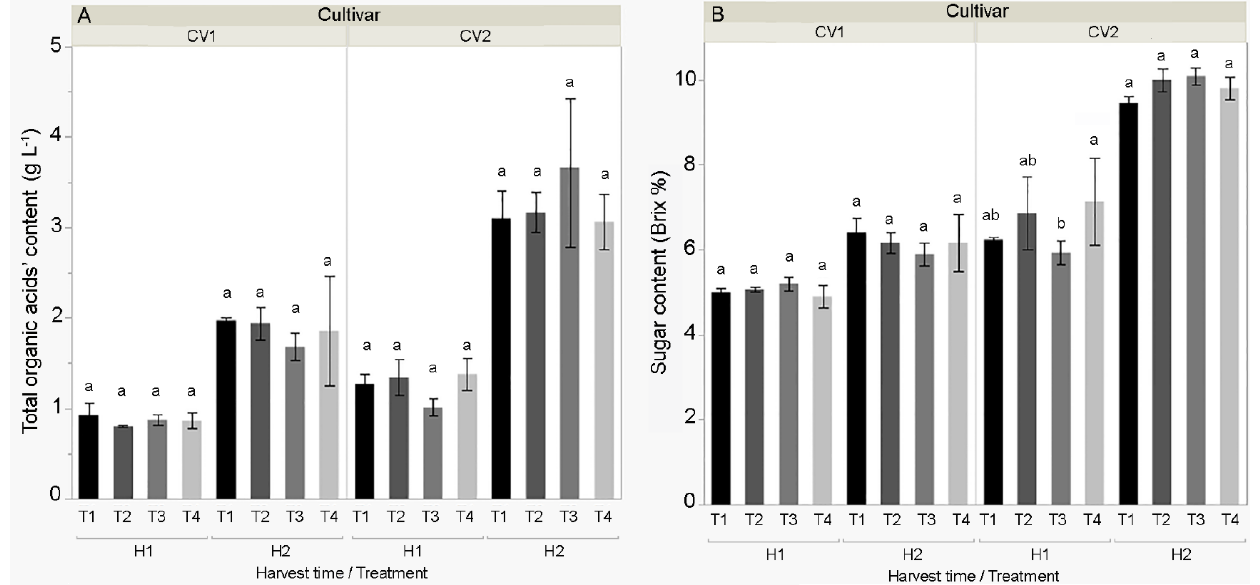
Figure 3. ( A ) Total organic acids’ content (g L −1 ) and ( B ) sugar content (% Brix) of sweet pepper cultivars CV1 (Šorokšari) and CV2 (Kurtovska kapija) fruits in H1 (first harvest at technological maturity) and H2 (second harvest at physiological maturity). The T1 (control), T2 (Eco Green, calcite nanoparticles at lower concentration), T3 (Eco Green, calcite nanoparticles at higher concentration), and T4 (Zeogreen+P, calcite-based foliar fertilizer) were applied three times during vegetation on sweet pepper plants. Post hoc comparisons of the means were performed using Tukey’s HSD test at p < 0.05; different letters indicate significant differences among treatments within each measurement